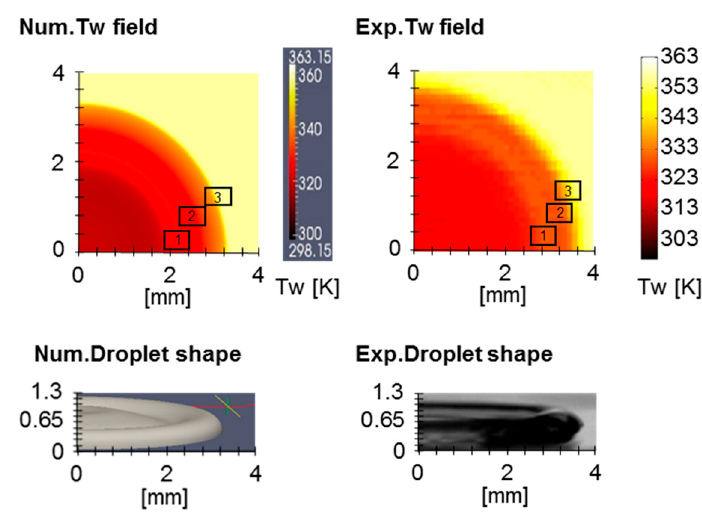
Figure 10. Details of the temperature distribution in the rim region as predicted by the numerical simulation and measured from the IR image (top). Spreading stage of the droplet from corresponding high speed image.